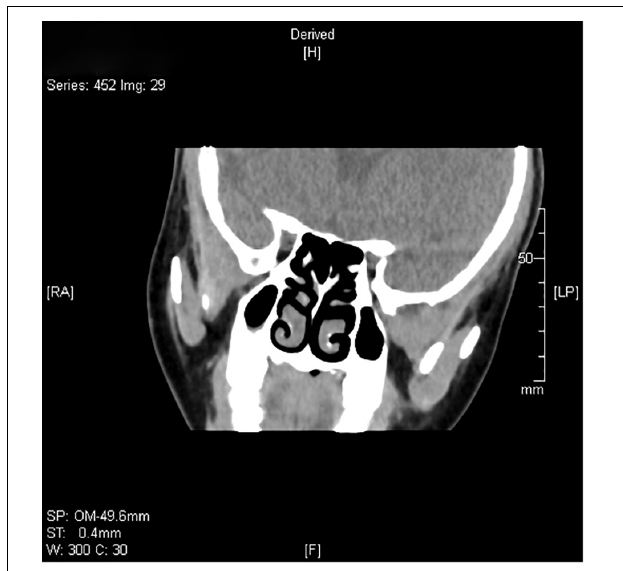
FIGURE 3 | Computed tomography scan of the abdomen showing liver on the left.